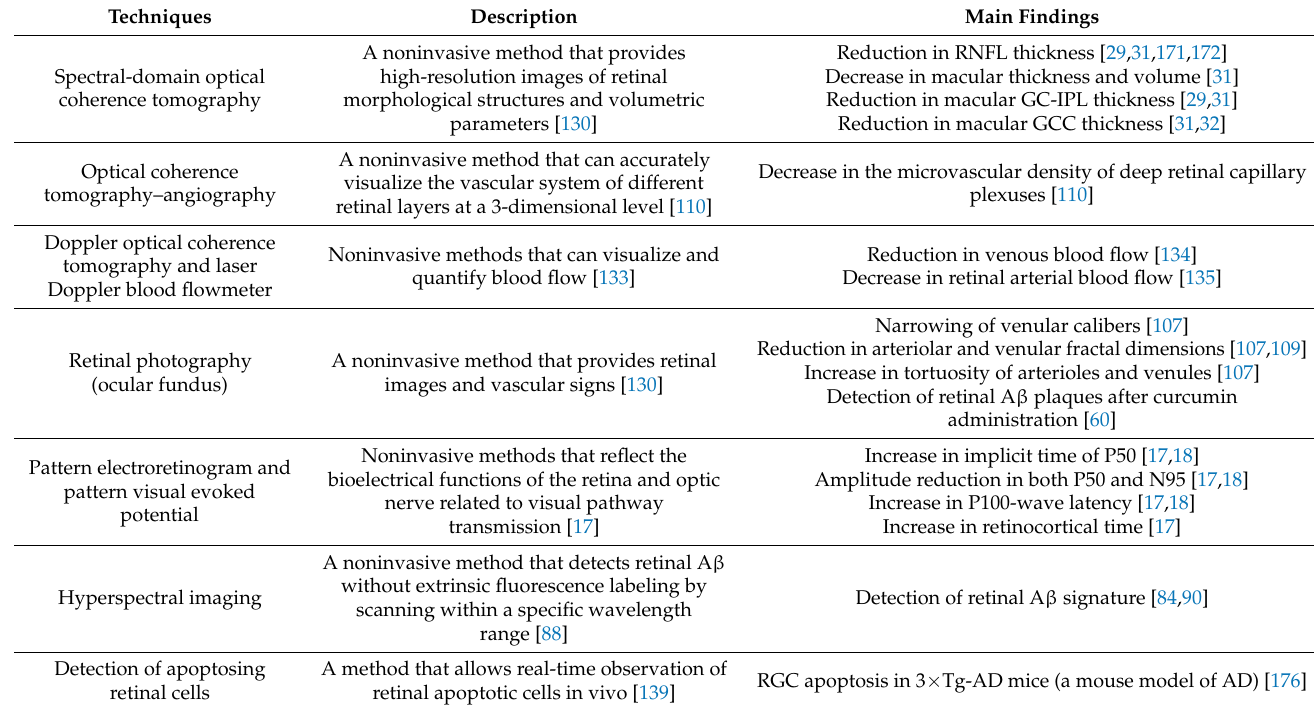
Figure 1. Schematic summary of retinal abnormalities in Alzheimer’s disease. In Alzheimer’s disease (AD) pathogenesis, amyloid-beta (A β ) deposition and tau aggregation induce pathological cascades including neuronal inflammation as well as mitochondrial dysfunction and oxidation, which ultimately result in neuronal loss and degeneration. Meanwhile, in AD, the retina manifests electroretinographic changes, retinal thinning, and vascular changes. ERG, electroretinogram; GCC, ganglion cell complex; GC-IPL, ganglion cell–inner plexiform layer; PERG, pattern electroretinogram; PVEP, pattern visual evoked potential; RNFL, retinal nerve fiber layer; ROS, reactive oxygen species. Table 3. Description of potential techniques for monitoring Alzheimer’s